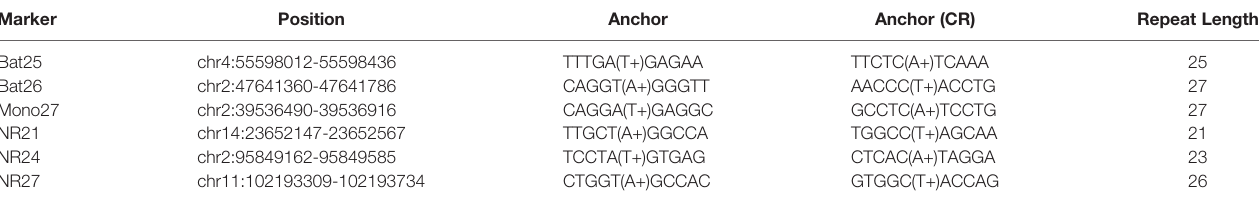
TABLE 2 | Anchor sequences for each marker for obtaining peak. CR, complementary